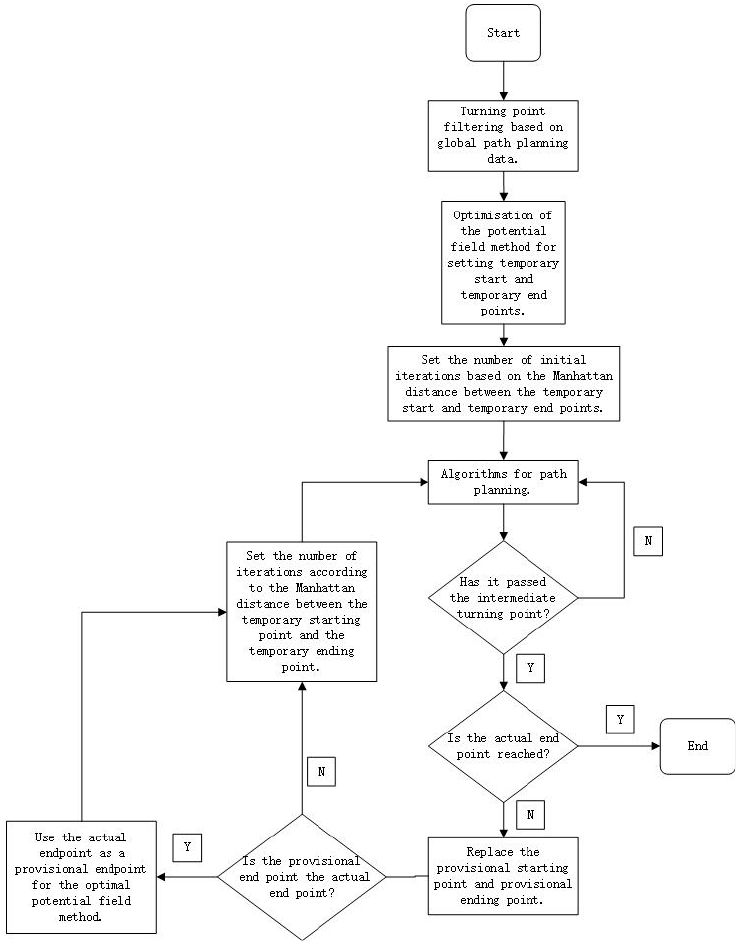
Figure 7. Optimization of the potential field method path-planning process. 283 The optimized potential field method changes the start and end points in pathfinding 284 and solves the problem of falling into local optima and unreachable target points by set- 285 ting parameters such as step size reasonably. At the same time, the optimized potential 286 field method takes the path obtained from global planning as the general direction, so it 287 also limits the pathfinding range of local paths and avoids crossing between multiple ob- 288 stacles. At the same time, since the potential field method gives the mobile robot a repul- 289 sive force during path planning, pushing the robot away from the obstacle appropriately, 290 the fusion algorithm page solves the problem of narrower paths for the mobile robot to